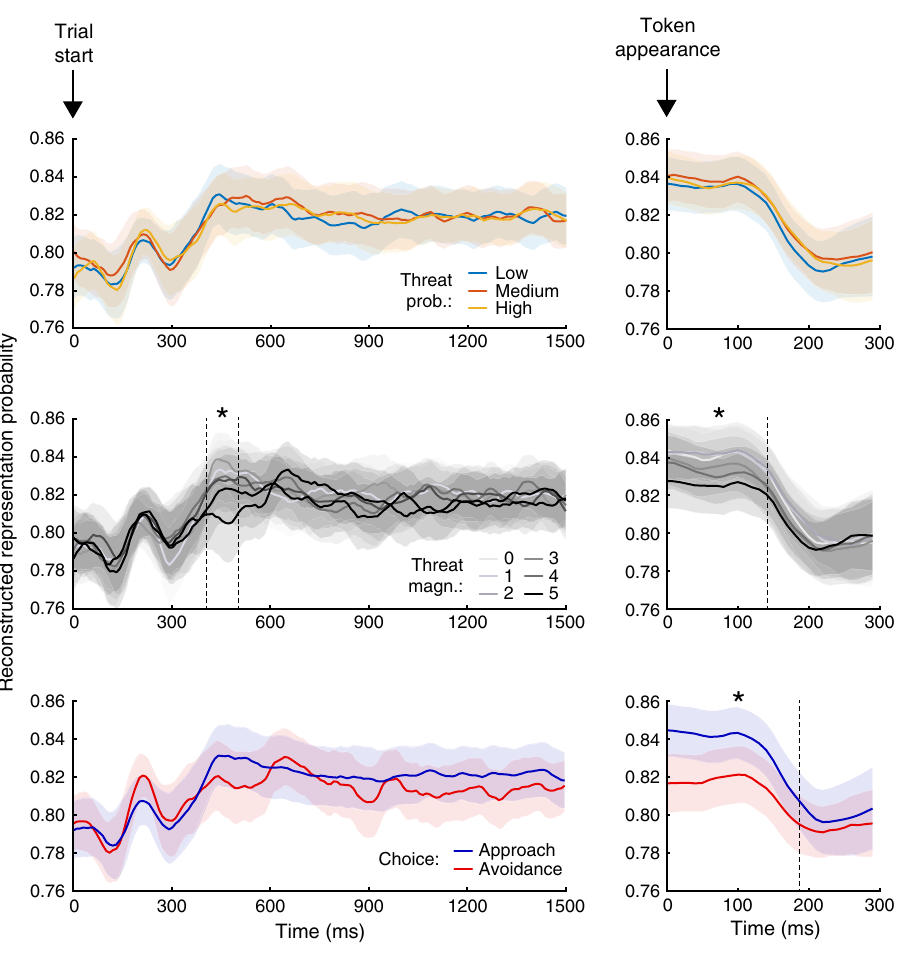
Fig. 4 Decoded outcome representation probabilities. Displayed are the probabilities that the MEG fi eld patterns during deliberation represents the positive outcome ( p (Positive); p (Negative) = 1 – p (Positive)), for epochs between 0 and 1500 ms from trial start and between 0 and 300 ms from token appearance (note the different time scales in plots aligned to trial start or token appearance). The shaded areas indicate the s.e.m. of the corresponding probability; Intervals denoted with asterisk (*) illustrate epochs in which the effect of the corresponding manipulation was statistically signi fi cant in a cluster-level random permutation test across the entire